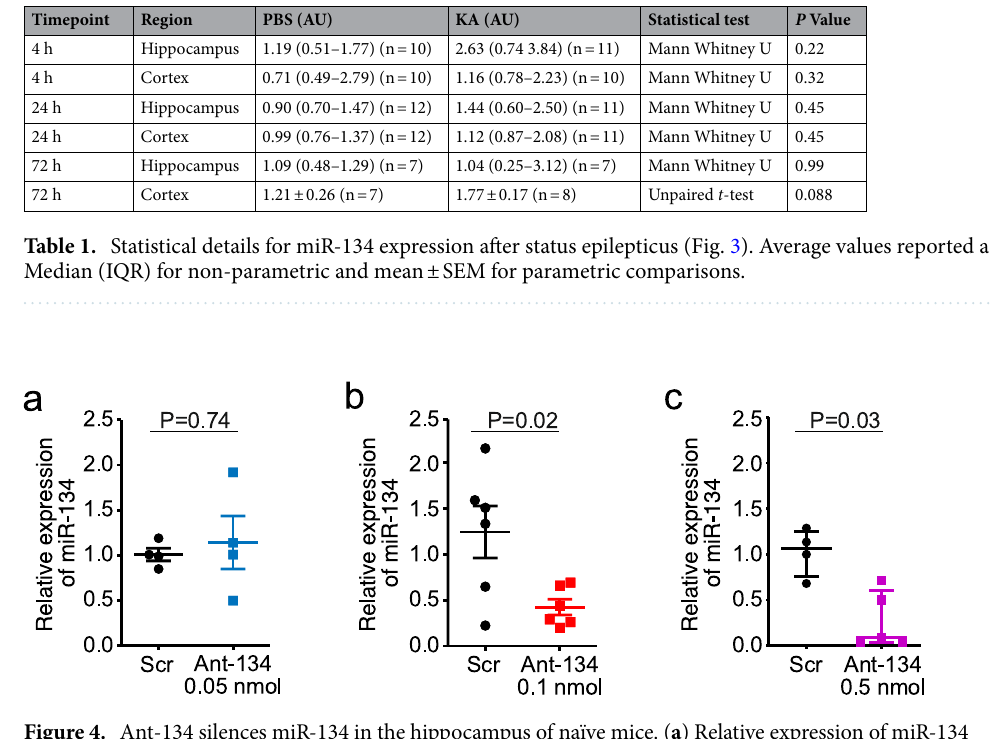
Figure 4. Ant-134 silences miR-134 in the hippocampus of naïve mice. ( a ) Relative expression of miR-134 following ICV injection of Scr/Ant-134 (0.05 nmol), (N = 4/group). ( b ) Relative expression of miR-134 following ICV injection of Scr/Ant-134 (0.1 nmol), (N = 6 [Scr] or N = 6 [Ant-134]. ( c ) Relative expression of miR-134 following ICV injection of Scr/Ant-134 (0.5 nmol), (N = 4 [Scr] or N = 5